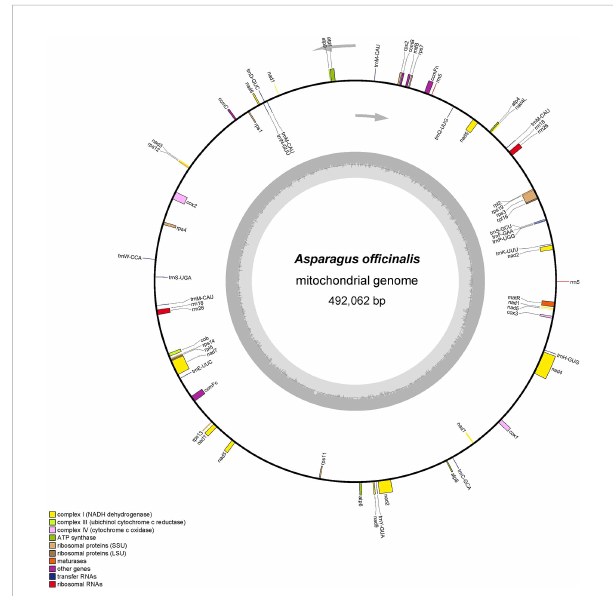
FIGURE 1 The mitochondrial genome organization structure of A. of fi cinalis . The protein-coding region is marked with green, rRNA is marked with red, tRNA is marked with pink, and the repeat region is marked with brown in the circular mitochondrial genome structure. The copy starting point and direction of the L-chain replication are shown by a gray